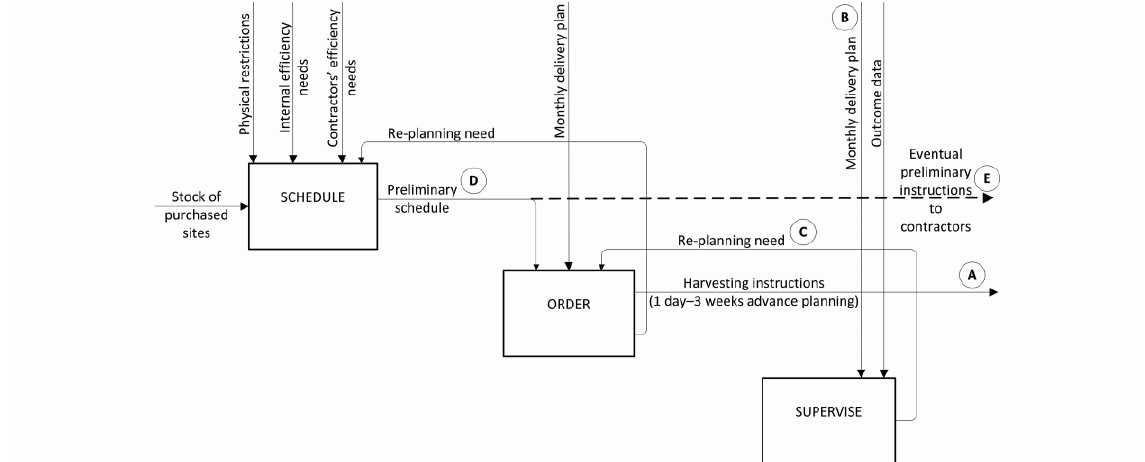
Figure 11. Sub-activities in the Manage harvesting operations activity. Arrows A–E mark information flows that varied in content and frequencies between FOA